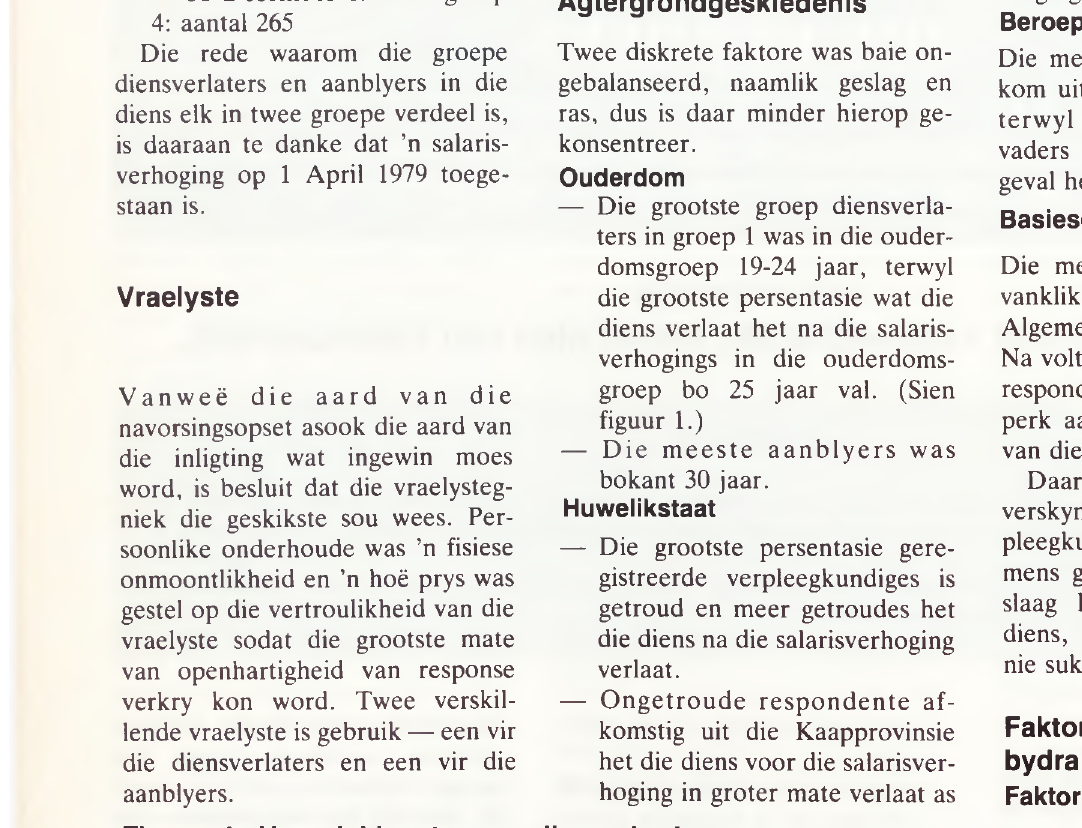
Figuur 1: Vergelyking tussen die ouderdomme van geregis­ treerde verpleegkundiges wat die diens tussen 1 Jan — 31 Maart en 1 April — 31 Des 1979 verlaat het